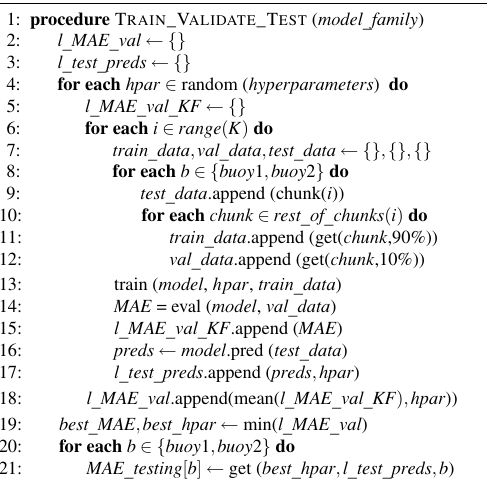
Figure 2. Dataset division.